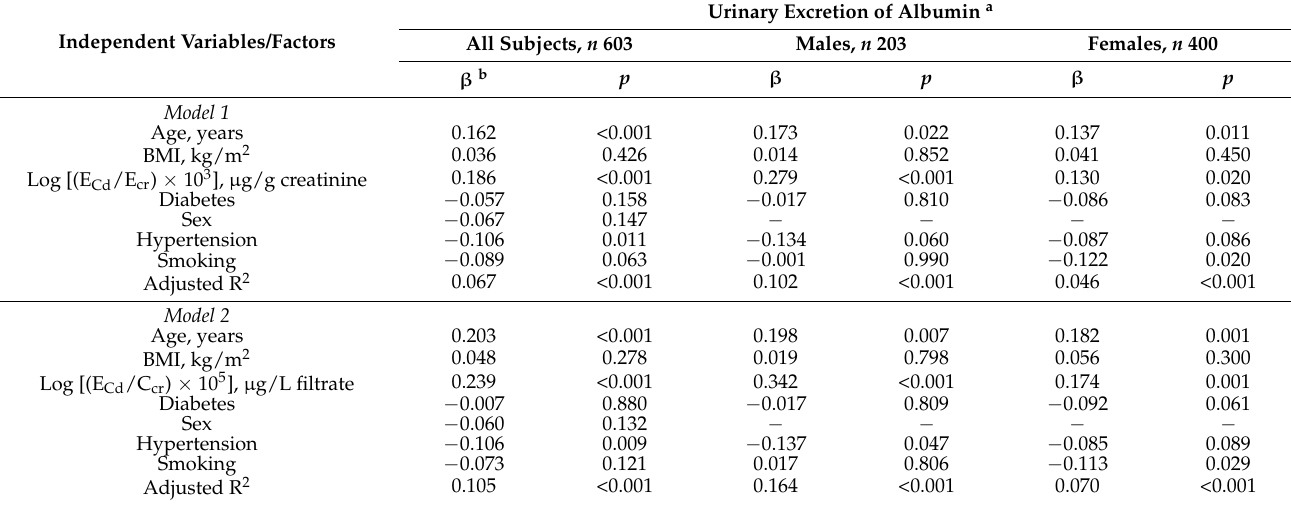
Table 3. Multiple regression model analysis of albumin excretion.